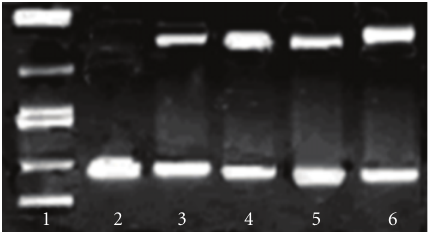
Figure 8: Cleavage of SC pUC19 DNA (50 μ M) by platinum com- plex (100 μ M) in the presence of H 2 O 2 (100 μ M), in 10 mM Tris- HCl/1 mM EDTA bu ff er (pH 8.0). lane 1: DNA Marker; lane 2: DNA control; lane 3: DNA + complex; lane 4: DNA + complex 1 + H 2 O 2 ; lane 5: DNA + complex + H 2 O 2 + DMSO (4 μ L); lane 6: DNA + complex 1 + H 2 O 2 + NaN 3 (100 μ